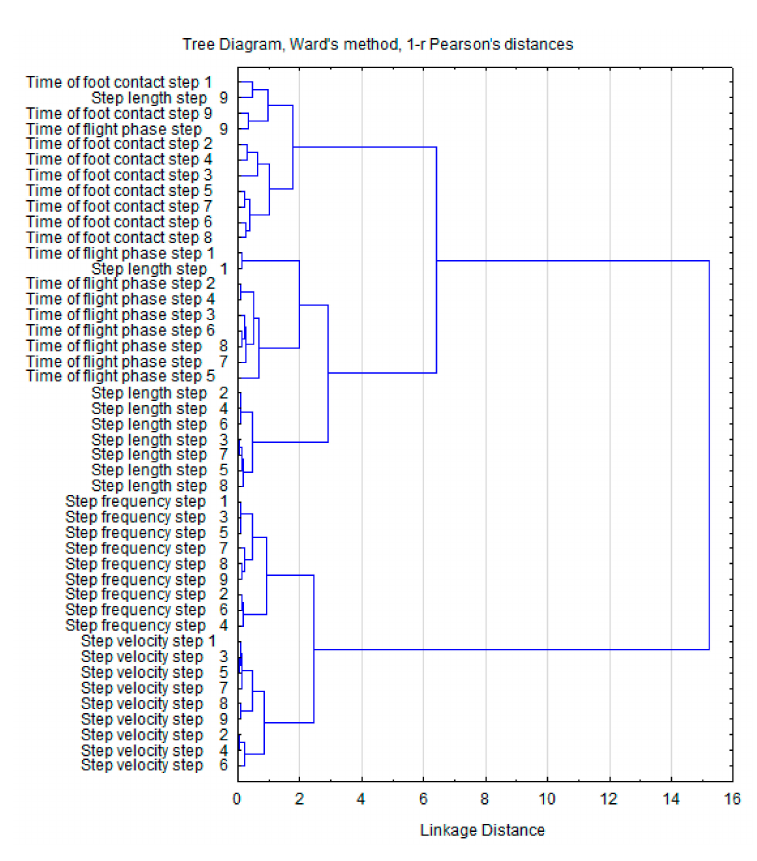
Figure 2. Dendrogram clustering of pre-test sprint step